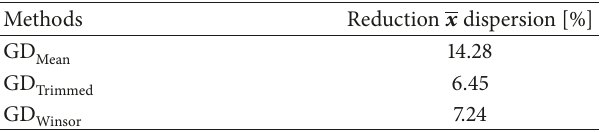
Table 22: Log-normal with 20 points.